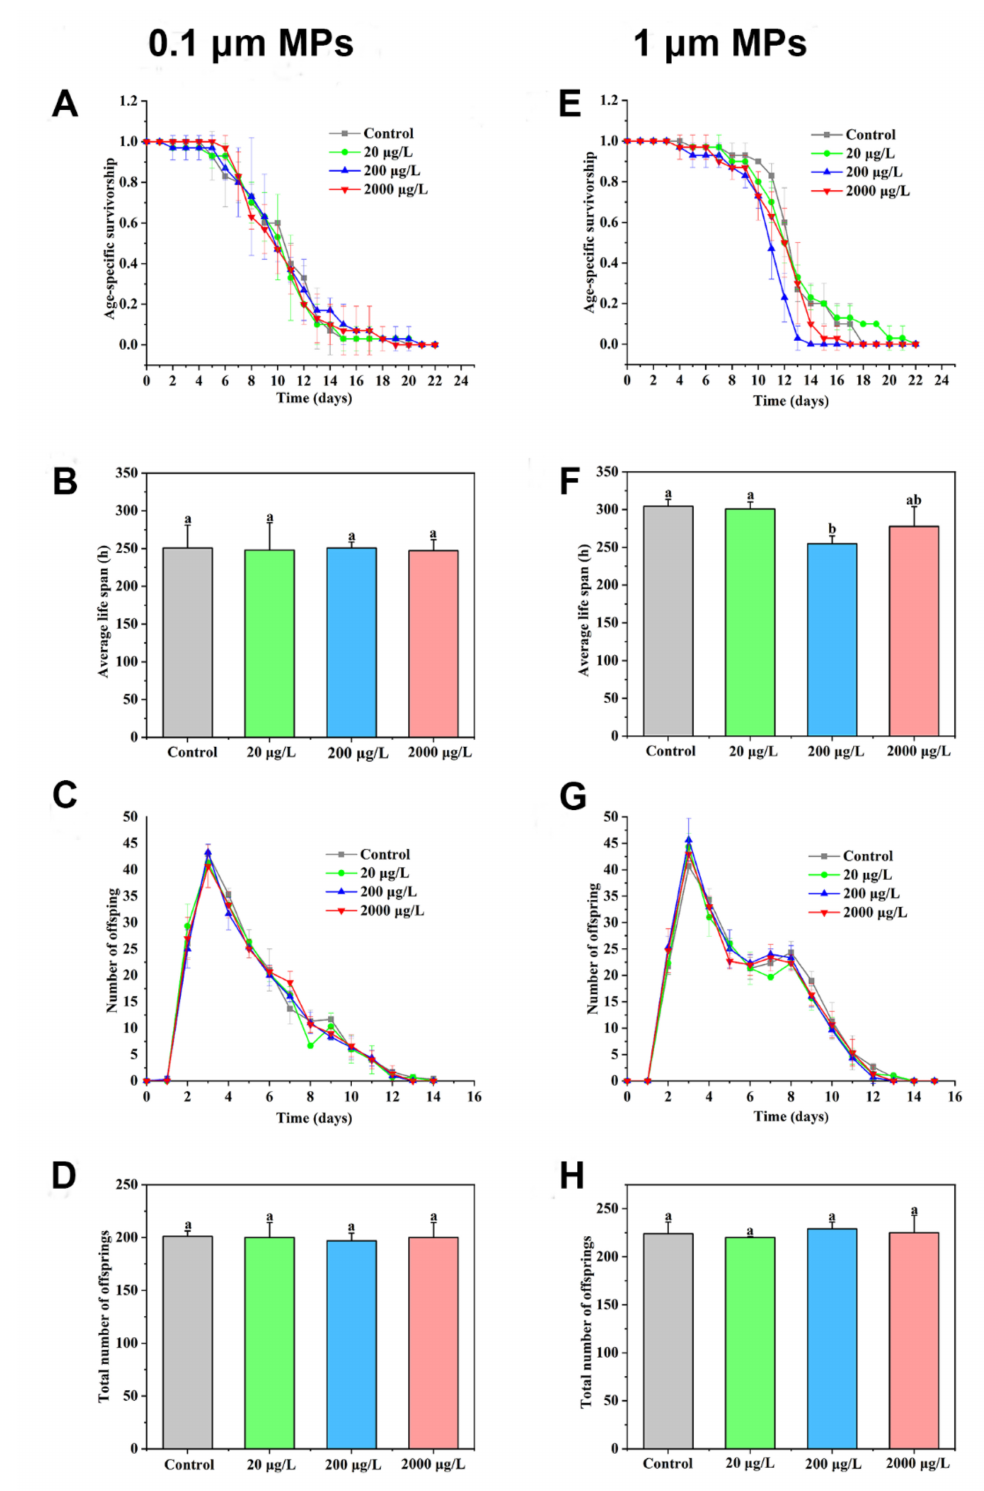
Figure 3. Effect of different concentrations of 0.1- µ m MPs ( A – D ) and 1- µ m MPs ( E – H ) on the survival and reproduction of rotifers (n = 30): ( A , E ) age-specific survivorship; ( B , F ) average lifes- pan; ( C , G ) daily number of offspring; ( D , H ) total number of offspring. Data are expressed as the mean ± SD of three parallel experiments. Different lowercase letters represent significant differences between experimental groups ( p <